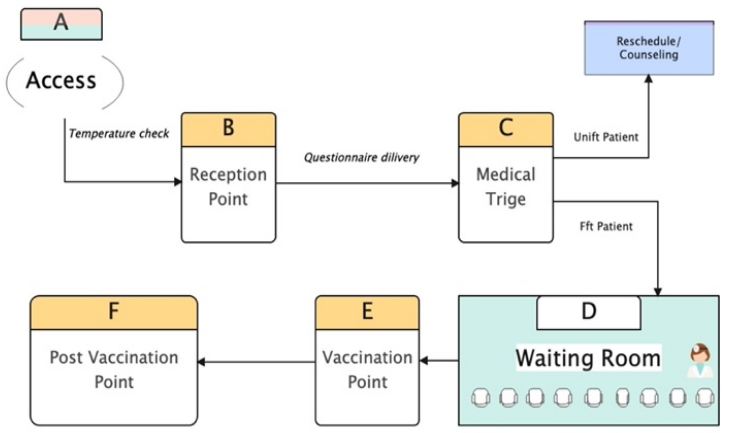
Figure 2. Proposed patient traffic flow.